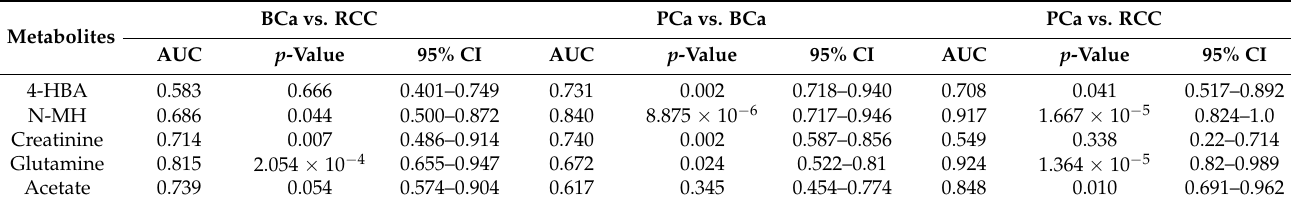
Table 2. Significance assessment of univariate receiver operating characteristic (ROC) curve analysis for metabolites potentially distinguishing between BCa, PCa, and